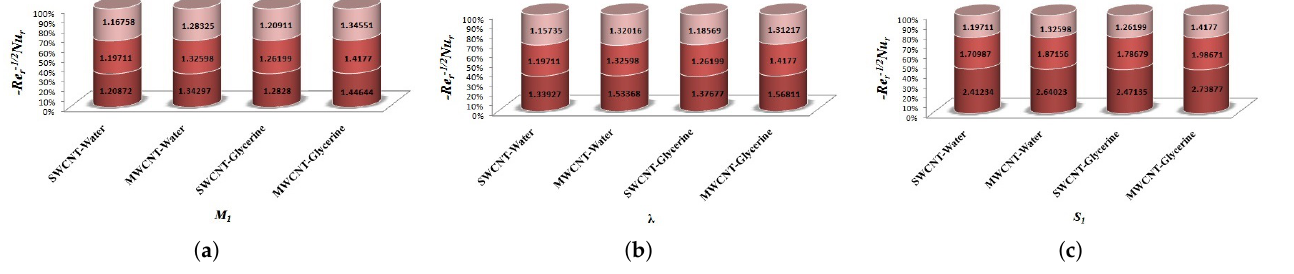
Figure 30. Impact of M 1 , λ , S 1 on Nusselt number.